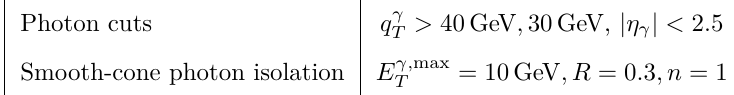
Table 3. Fiducial cuts for H → γγ at